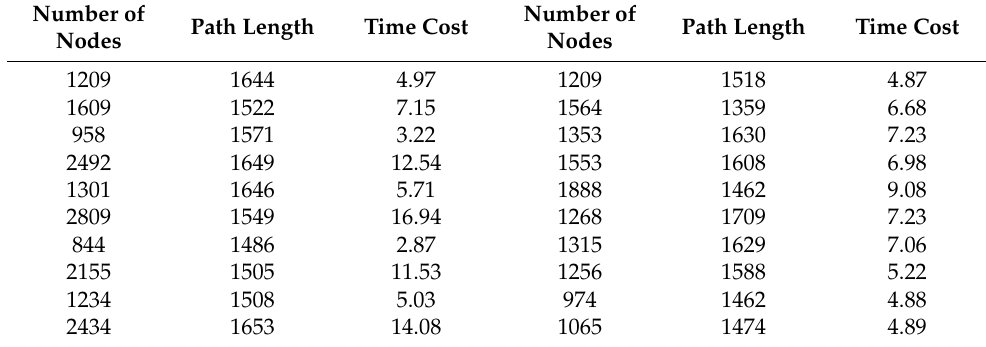
Table 2. Number of nodes, path length, and time cost of the conventional RRT algorithm.